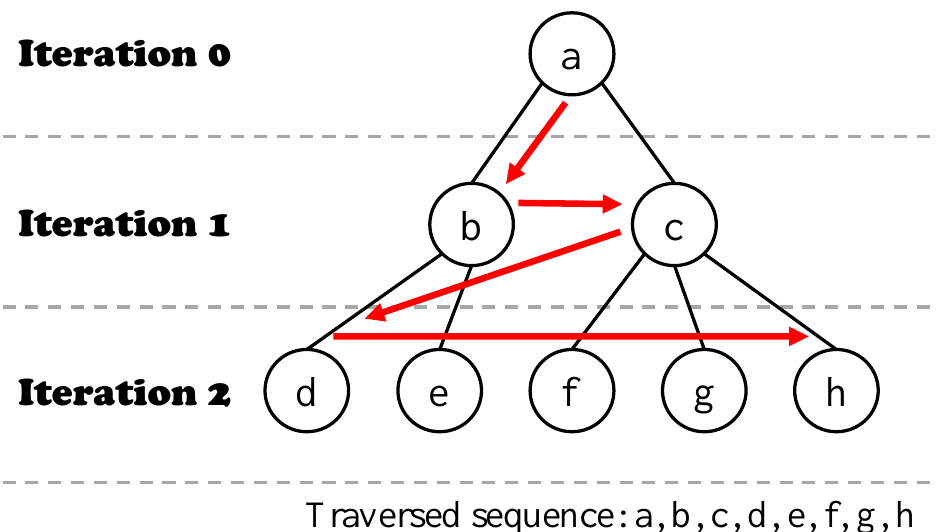
Figure 1. Example of breadth-first search. Red arrows indicate the traversal sequence during